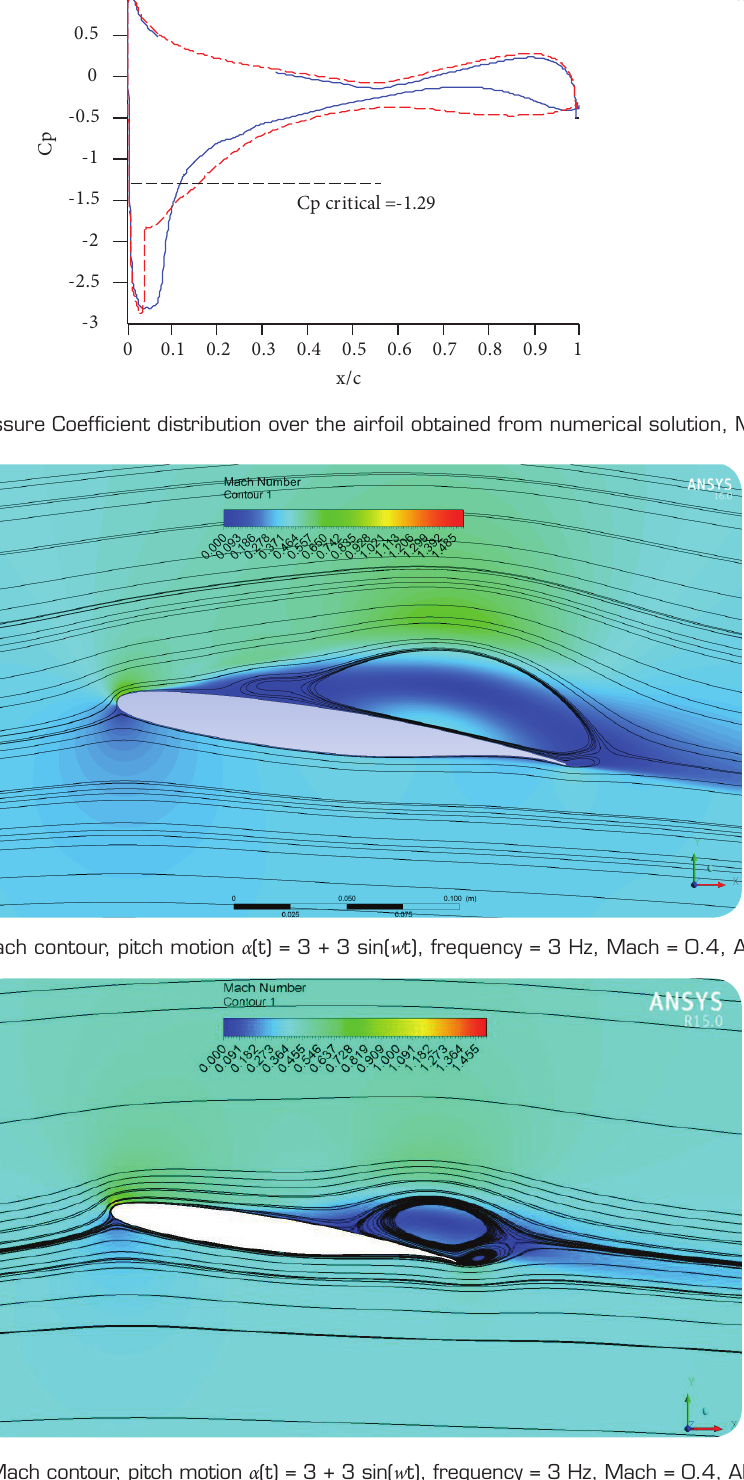
Figure 34. Mach contour, pitch motion α(t) = 3 + 3 sin( w t), frequency = 3 Hz, Mach = 0.6, Alpha =